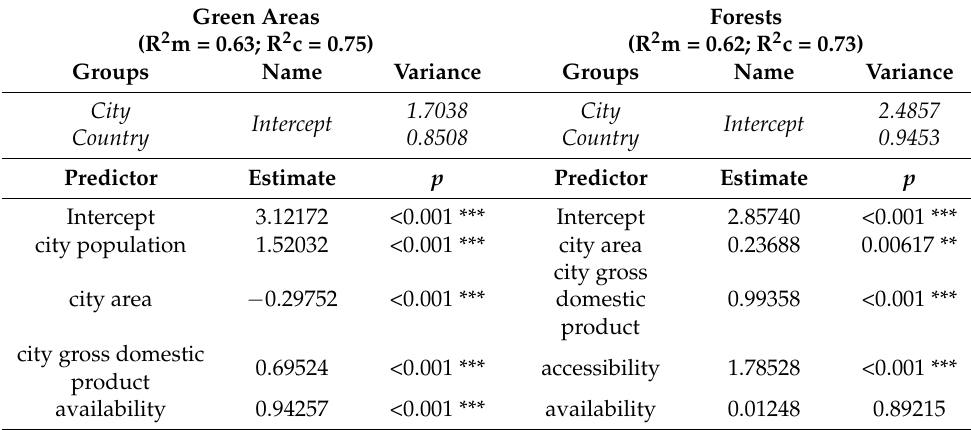
Table 3. Results of the Poisson generalized mixed effects model for the number of observations in green areas and forests in each city (N = 672). The factor “country” was also added to introduce an additional random effect. Significance of the models is reported. (*): p < 0.05; (**): p < 0.01; (***): p < 0.001. R 2 m and R 2 c stand for marginal and conditional R 2 s, respectively. Characters in italics indicate random effects. For green areas, fixed effects alone explain 63% of the variance; the variance explained increases to 75% when accounting for unmeasured effects related to country. For forests, fixed effects alone explain 62% of the variance; the variance explained increases to 73% when accounting for unmeasured effects related to country. Green Areas Forests (R 2 m = 0.63; R 2 c = 0.75) Groups Name Variance Groups Name